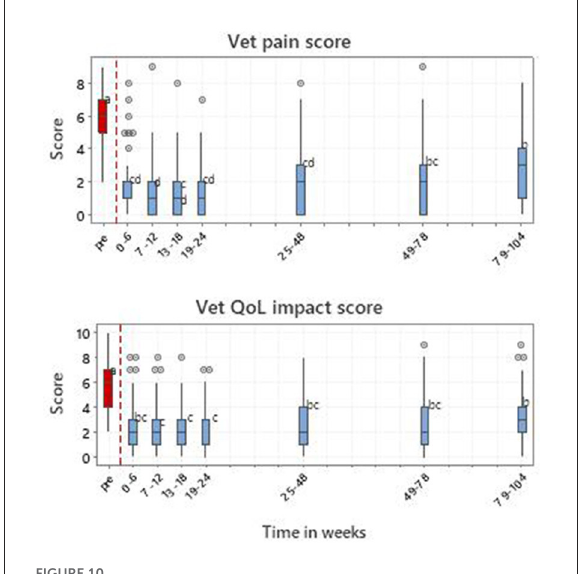
FIGURE10 Vet-assessed pain and QOL impact scores for 223 dogs with MSD treated with RM in time windows representing pretreatment (pre) and up to 104 weeks post initial treatment. Letters adjacent to each bar indicate which time windows are significantly different (i.e., those not sharing a common letter).